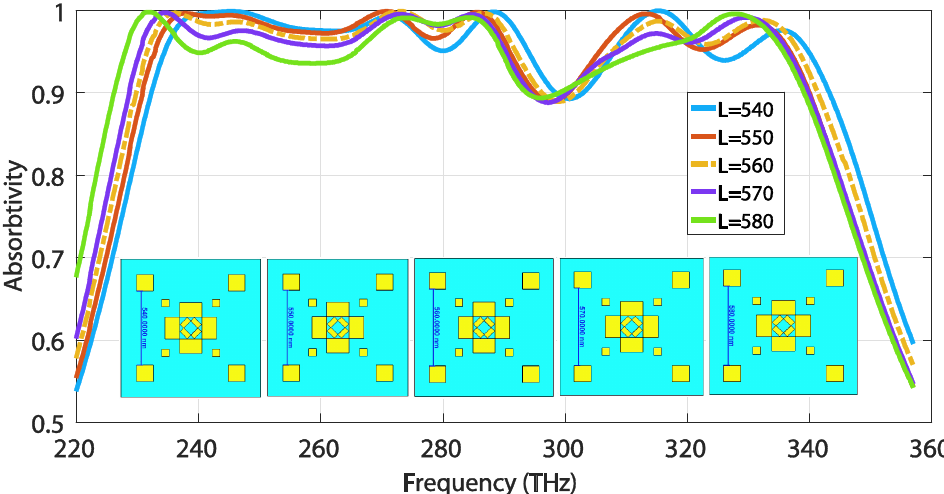
Figure 9. Absorption sensitivity to the lateral distance denoted by L.